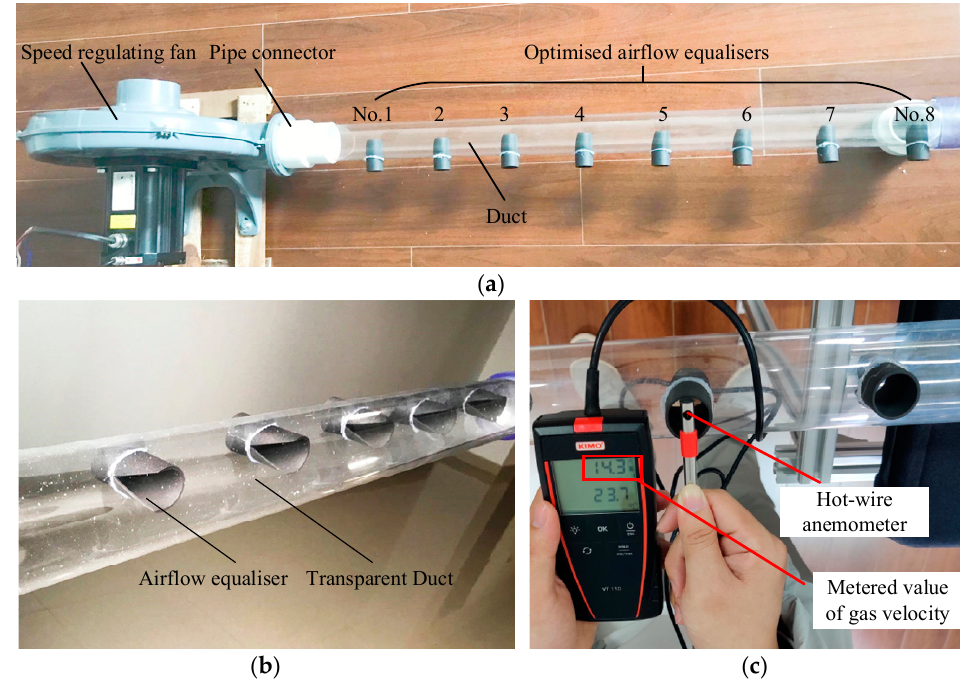
Figure 5. Measurement of the sectional gas velocities in the bench test: ( a ) Pneumatic conveying Line. ( b ) Optimised airflow equalisers punched and embedded in the transparent duct. ( c ) Measurement of sectional gas velocity at an airflow outlet from a branch pipe using the hot-wire anemometer.